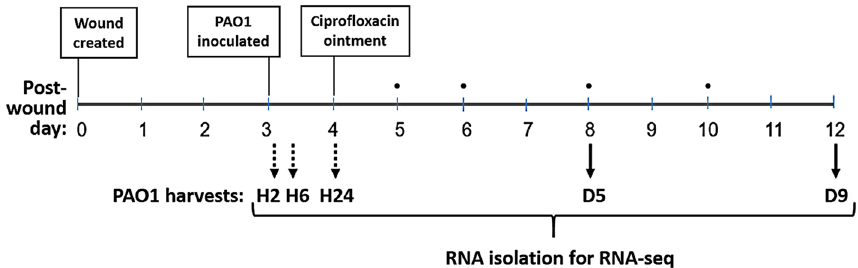
Figure 1. Study design . PAO1 from log-phase culture was pipetted (10 6 CFU) into full-thickness excision wounds (rabbit ear) on post-wounding day 3. The bacteria were harvested at post-inoculation Hours 2, 6, and 24 (dotted black arrows). Other wounds infected for 24 h were treated for 24 h with topical ciprofloxacin ointment (Ciloxan), and then dressings were changed every day or two (TELFA AMD, black dots) until the bacteria were harvested on post-inoculation Days 5 and 9 (solid black